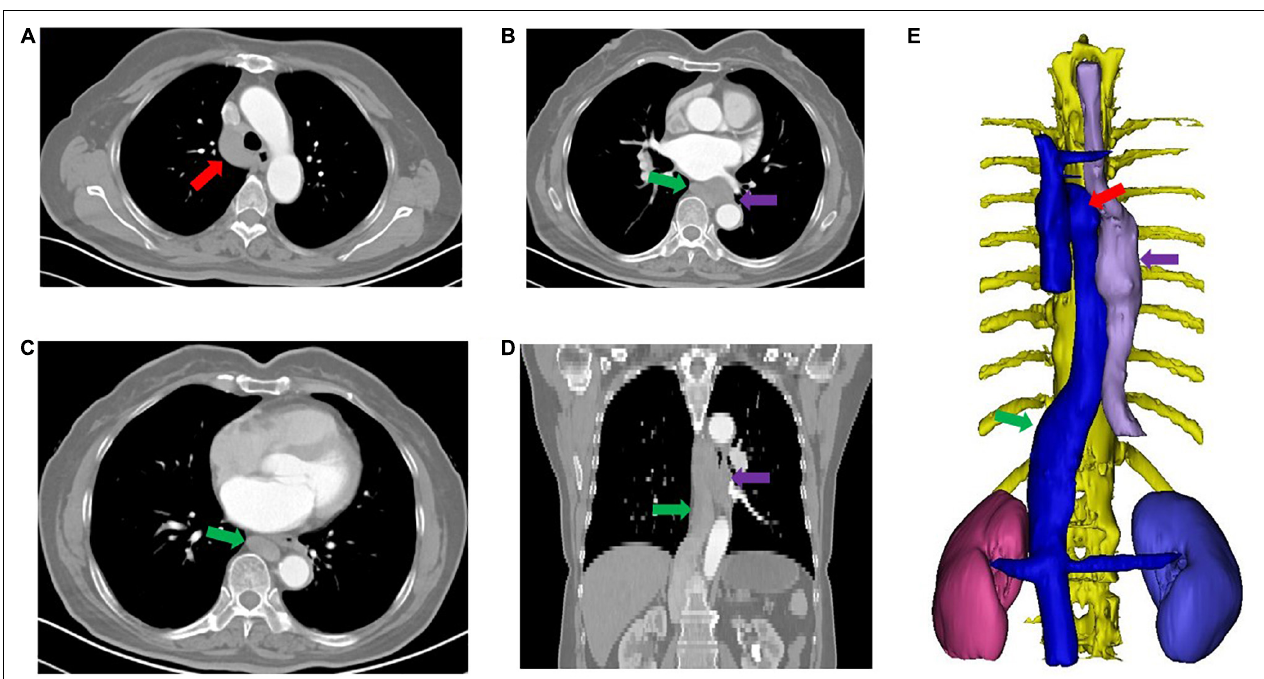
FIGURE 1 | CT reconstruction showing azygos continuation of the inferior vena cava (not preoperatively recognized). (A–D) Show the enlarged arch of the azygos vein and azygos vein. (E) Shows hepatic segment absence of the inferior vena cava with azygos continuation. The red arrow shows the enlarged arch of the azygos vein; the green arrow shows the azygos vein; the purple arrow shows the